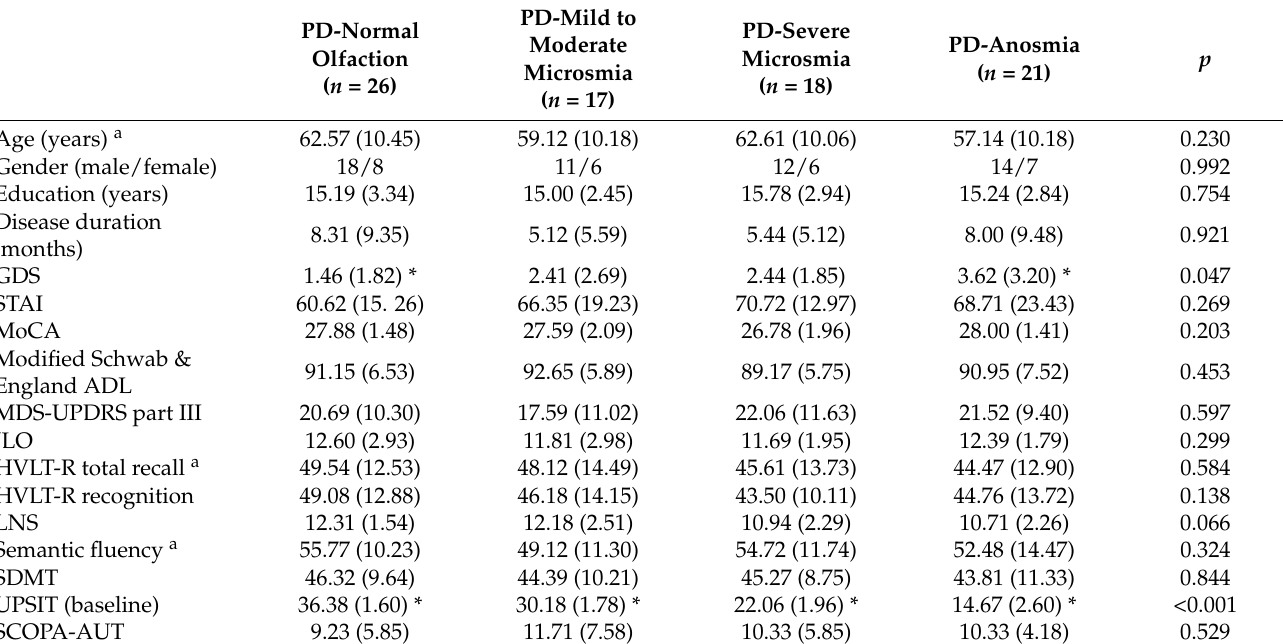
Table 1. Demographic and neuropsychological